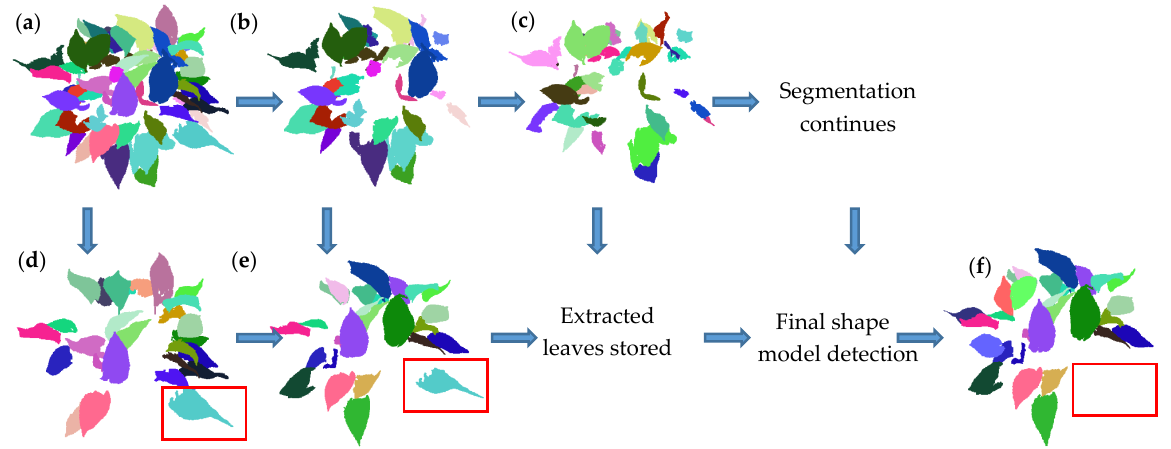
Figure 5. Schematic diagram of the multi-level region growing segmentation. ( a ) Initial segmentation results ( ε a = 1.5 ς and ε b = 1.5 ρ) ; ( b ) the data for the second segmentation; ( c ) the data for the third segmentation; ( d ) the automatically selected leaves after the initial segmentation based on the initial shape models; ( e ) the automatically selected leaves after the second segmentation ( ε a = 1.45ς and ε b = 1.45 ρ) based on the second shape models; ( f ) the automatically selected typical leaf samples after the final segmentation based on the final shape models. The red boxes mark a cluster considered as a typical leaf sample during the multi-level segmentation process but removed at last.